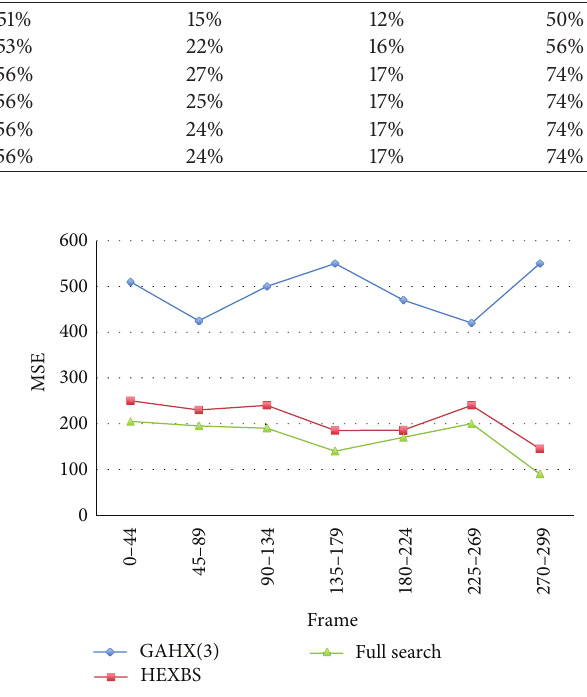
Figure 22: Average MSE per block compared with different meth- ods for Bus video sequence.